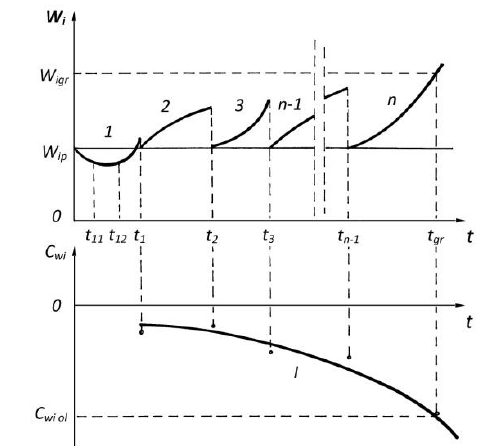
Fig. 3. Graphic interpretation of changes in the index of change intensity of oil properties: W p – preliminary index value, W k1 , W k2 ,..., W kn – end value of index of oil technical condition at the moment 1, 2,..., n of oil change, t 1 , t 2 ,..., t n – moments of oil change in the engine, C W – index of